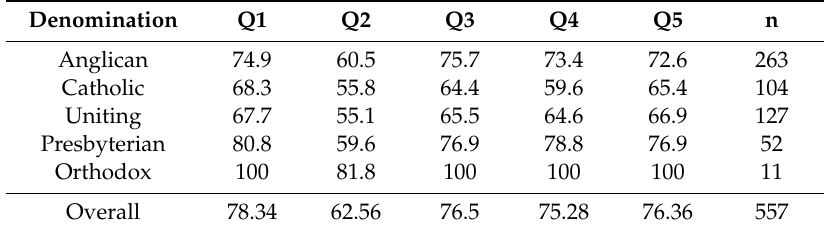
Table 2. Percentages of respondents who completed free-form comments for each open-ended